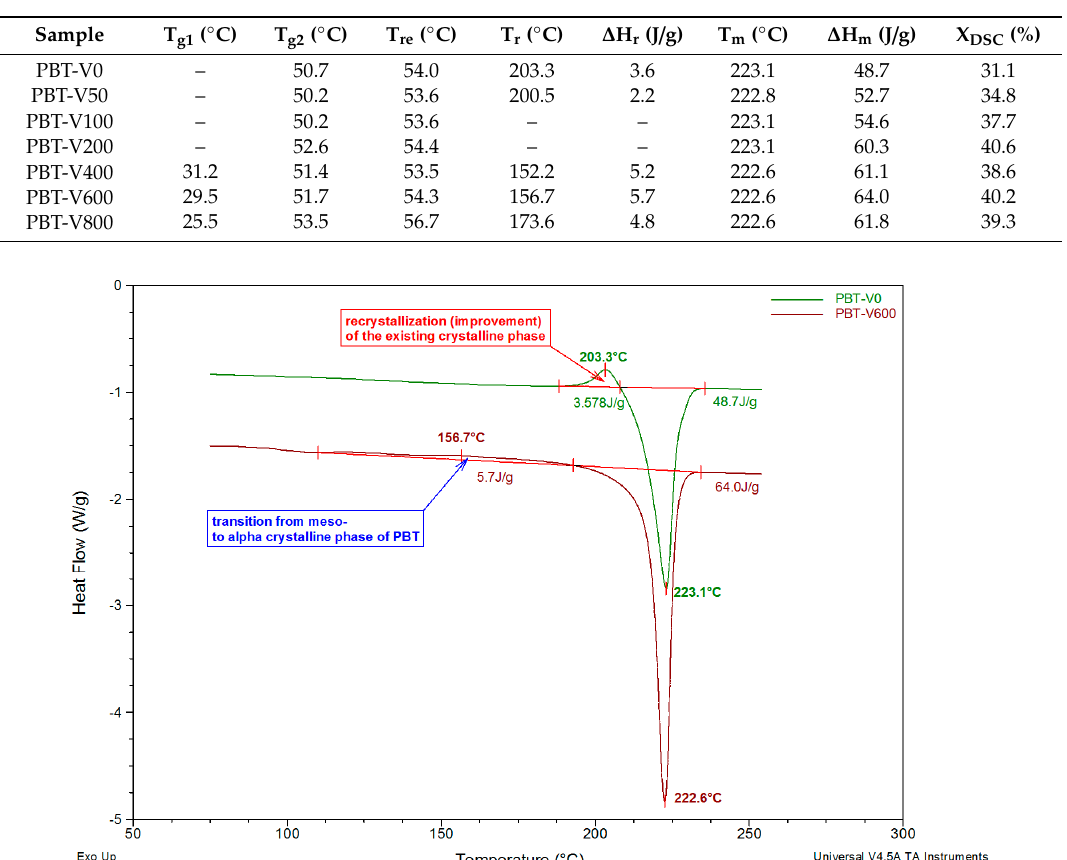
Figure 5. DSC curves of poly(butylene terephthalate) fibers formed at different take-up velocities. Table 1. Values of the characteristic temperatures of the glass transitions (T g1 , T g2 ), enthalpy relaxation peak (T re ), recrystallization (T r ) and melting (T m ), enthalpies of melting ( ∆ H m ), recrystallization ( ∆ H r ), and index of crystallinity (X DSC ) of studied PBT fibers, determined based on DSC measurements.